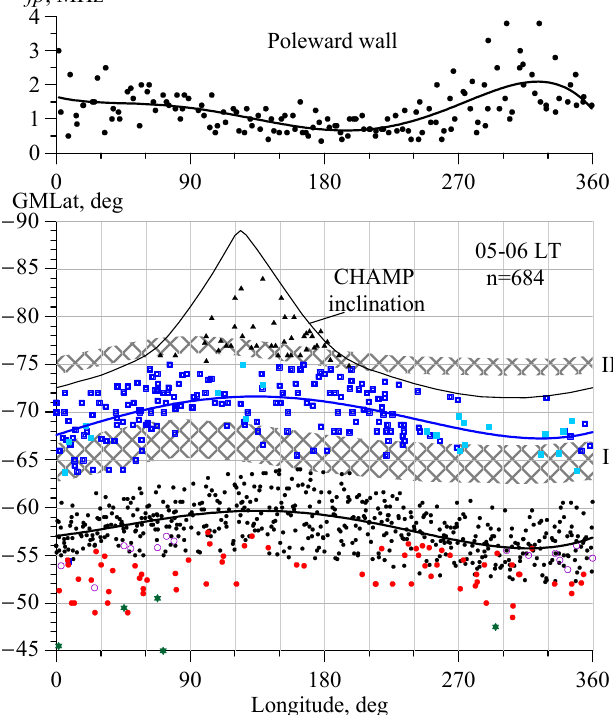
Figure 5. The same as in Figure 1, but for 05 ‒ 06 LT.